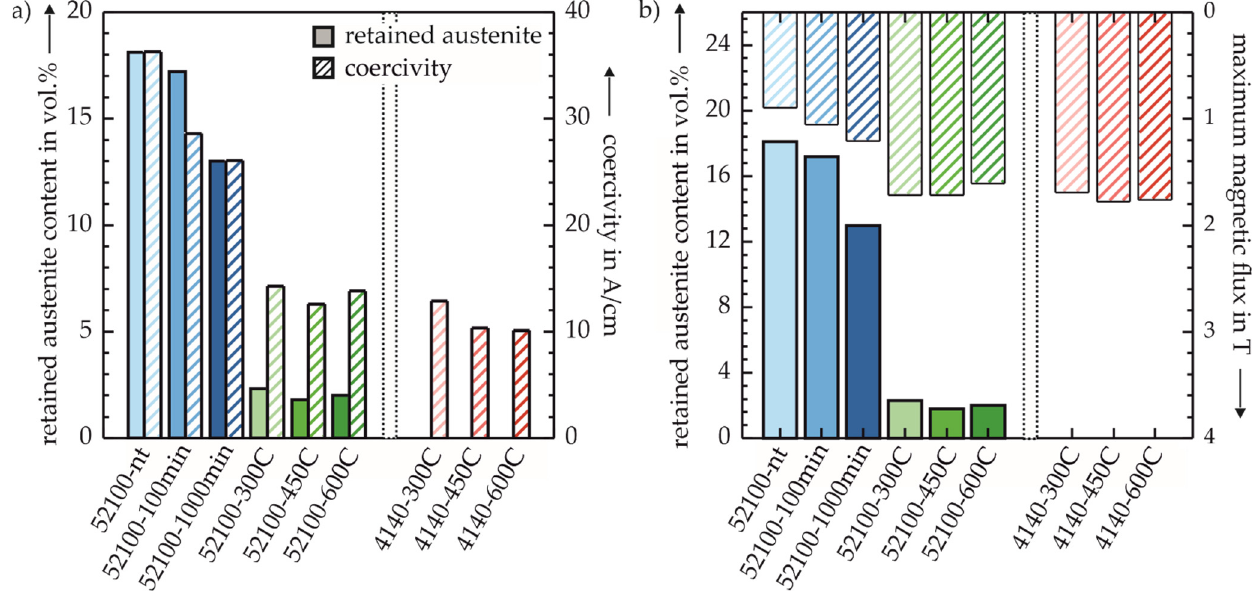
Figure 7. ( a ) RA content and magnetic coercivity determined at a constant magnetic flux (cf. Section 3.1.). ( b ) RA content and maximum flux determined from the magnetic hysteresis at constant M a and f (cf. Section 3.2.).